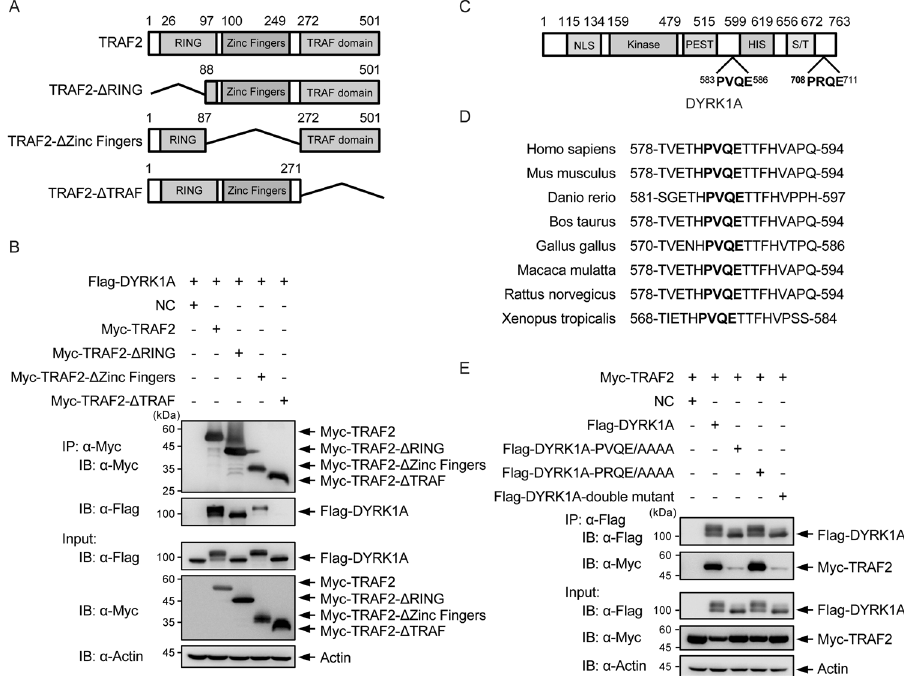
Fig. 2 TRAF2 interacts with DYRK1A by binding to TRAF domain-binding motif “ PVQE ” on DYRK1A. A Schematic representation of TRAF2 and its truncations. All constructs are Myc-tagged at N terminus. B TRAF2 domains mediating interaction with DYRK1A. Myc-TRAF2 and Myc- TRAF2 deletion constructs were af fi nity puri fi ed from cells co-transfected with Flag-DYRK1A and probed with α -Myc and α -Flag antibodies. All TRAF2 constructs, except Δ TRAF, immunoprecipitated Flag-DYRK1A. C Schematic representation of DYRK1A with putative TRAF2-binding motifs marked. D Sequence alignment of the major TRAF2-binding motif shows sequence conservation on DYRK1A. Conserved motif is highlighted bold. E TRAF2 interaction with PVQE motif on DYRK1A. Flag-DYRK1A, Flag-DYRK1A-PVQE/AAAA, Flag-DYRK1A-PRQE/AAAA, and double mutant were co-expressed with Myc-TRAF2, Flag-af fi nity puri fi ed, and probed with α -Myc antibody. Flag-DYRK1A-PVQE/AAAA and the double mutant have signi fi cantly diminished ability to pull down